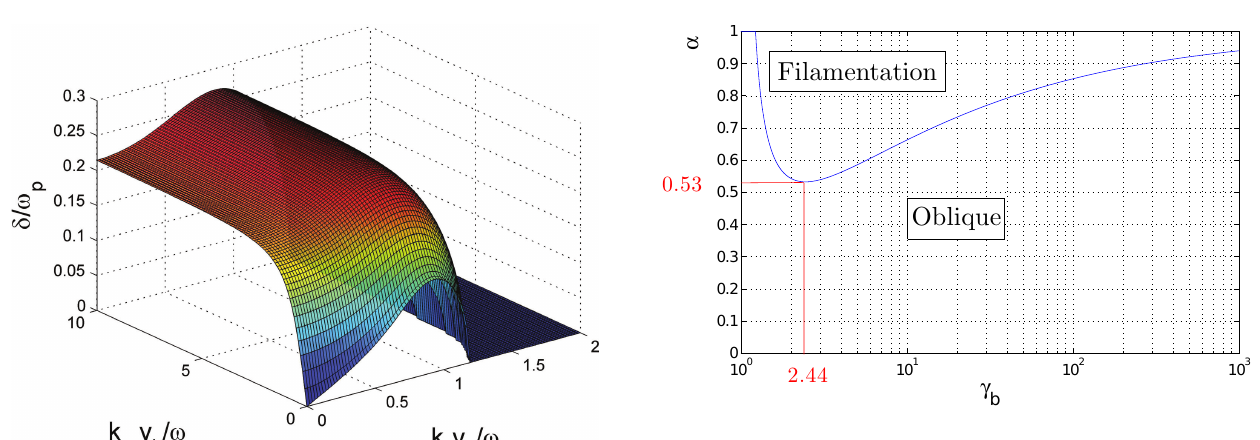
Fig. 2. Hierarchy map in the cold regime in terms of the beam Lorentz factor and the beam to plasma density ratio α . The non- relativistic regime γ b = 1 pertains to two-stream